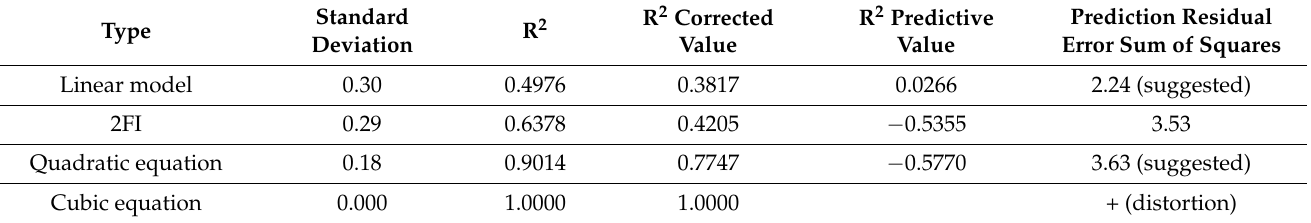
Table 13. R 2 comprehensive